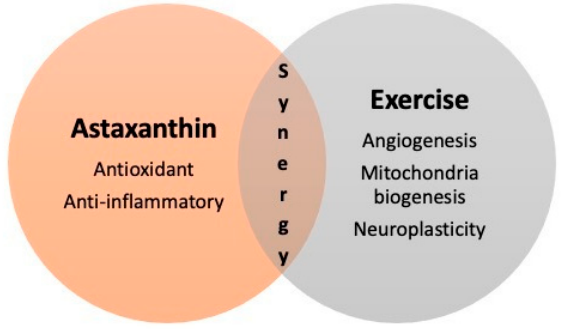
Figure 4. Potential additive or synergistic effects between ASX and exercise.